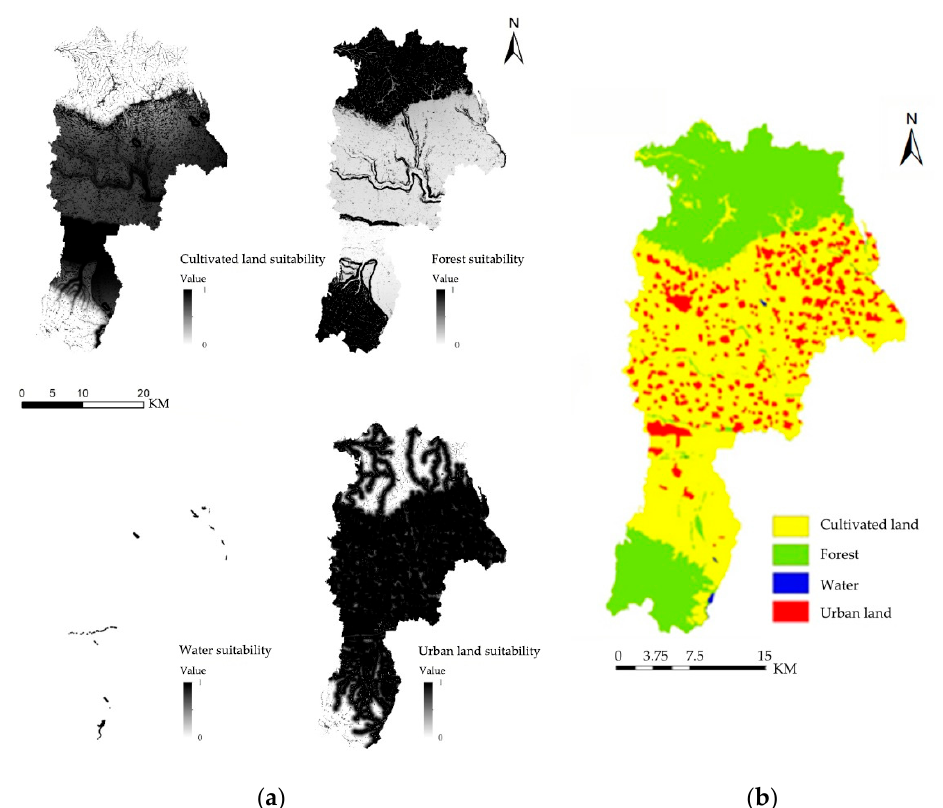
Figure 6. CA-Markov model establishment. ( a ) Suitability map for each land use type; ( b ) Simula- tion of land use map in